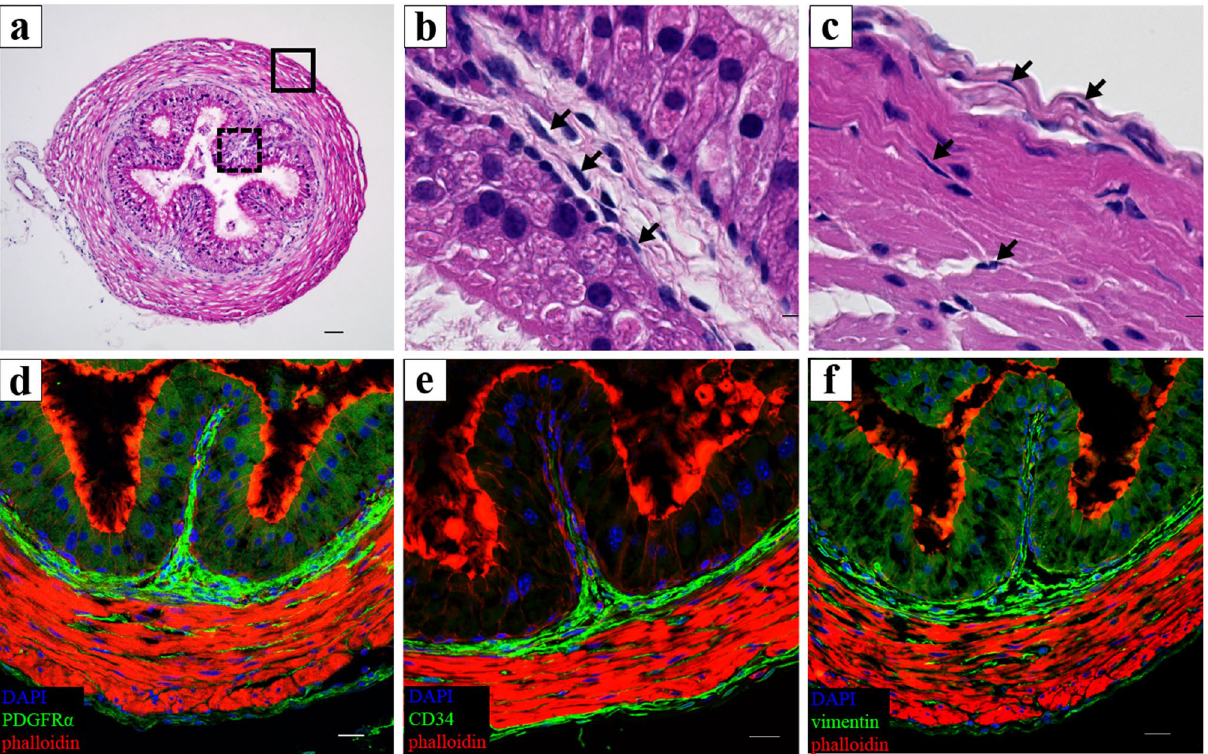
Figure 2. ( a ) The cross-sectional images of Hematoxylin and Eosin stained murine vas deferens. ( b ) High magnification of the solid black line square area of ( a ). Several cells with small cell bodies and elongated cellular processes were observed in the lamina propria ( b , black arrows). ( c ) High magnification of the dotted black square area. These cells were broadly distributed in the smooth muscle and serosal layers ( c , black arrows). ( d ) Representative image of the double immunolabeling for PDGFRα (green) and phalloidin (red). ( e ) Representative image of the double immunolabeling for CD34 (green) and phalloidin (red). ( f ) Representative image of double immunolabeling for vimentin (green) and phalloidin (red). Nuclei were counterstained in blue with 4 ′ ,6-diamidino-2-phenylindole ( d – f ). Immunoreactivities of all the markers observed in the lamina propria, the smooth muscle and the serosal layers ( d – f ). Scale bars: 50 µm ( a , d–f ), 5 µm ( b , c